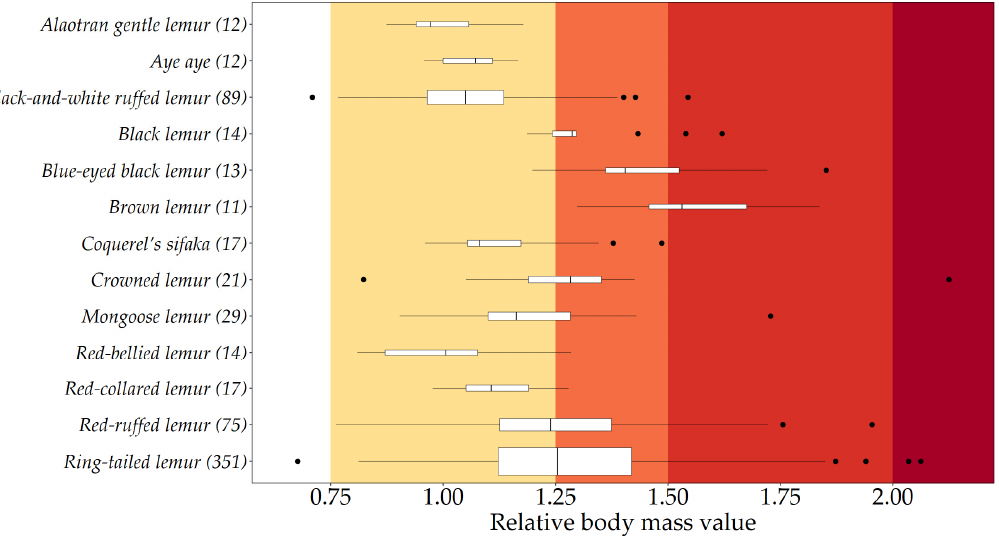
Figure 2. Box-and-whisker plots of relative body mass values of individual adult lemurs, from the 13 species featuring in our comparative analyses. Ring-tailed lemurs, mongoose lemurs, black-and-white ruffed lemurs, and red ruffed lemurs also featured in our epidemiological analyses. Sample sizes are shown in parenthesis next to species’ names, and are also are indicated by the relative width of their respective boxplot. Species’ medians are indicated by vertical lines on the boxes; the extent of the boxes indicate their interquartile ranges; whiskers represent values within 1.5 times the interquartile range; and outliers outside this are depicted as points. The healthy range (0.75–1.25) is shown by yellow shading; overweight by orange (1.25–1.5); obese by red (1.5–2); and morbidly obese (>2) by the darker red.